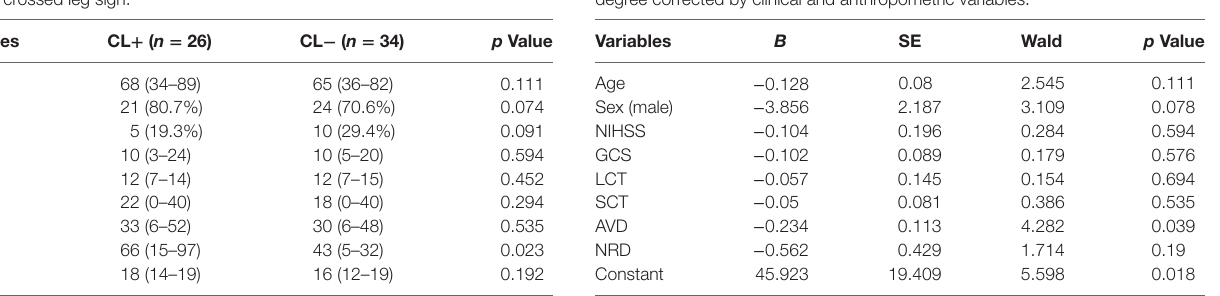
Wald, Wald test; NIHSS, National Institutes of Health Stroke Scale; LCT, line cancellation test; SCT, star cancellation test; AVD, absolute value of midline deviation; NRD, number of right deviation of the midline; GCS, Glasgow coma scale.